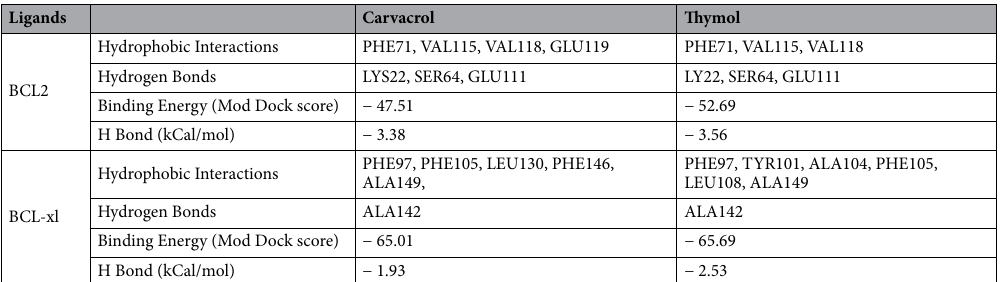
Table 2. The optimal binding energy, hydrophobic interactions and hydrogen bonds of BCL2 and BCL-xl residues with carvacrol and thymol.